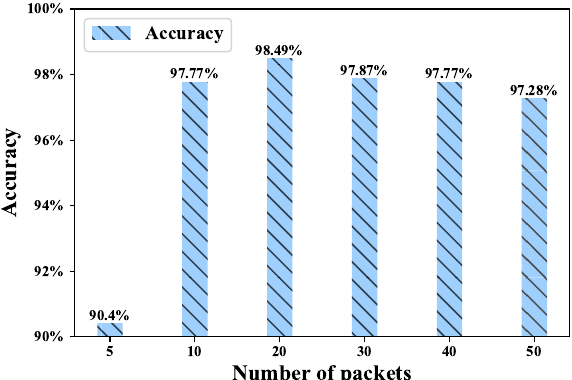
Figure 8. Accuracy over different packet